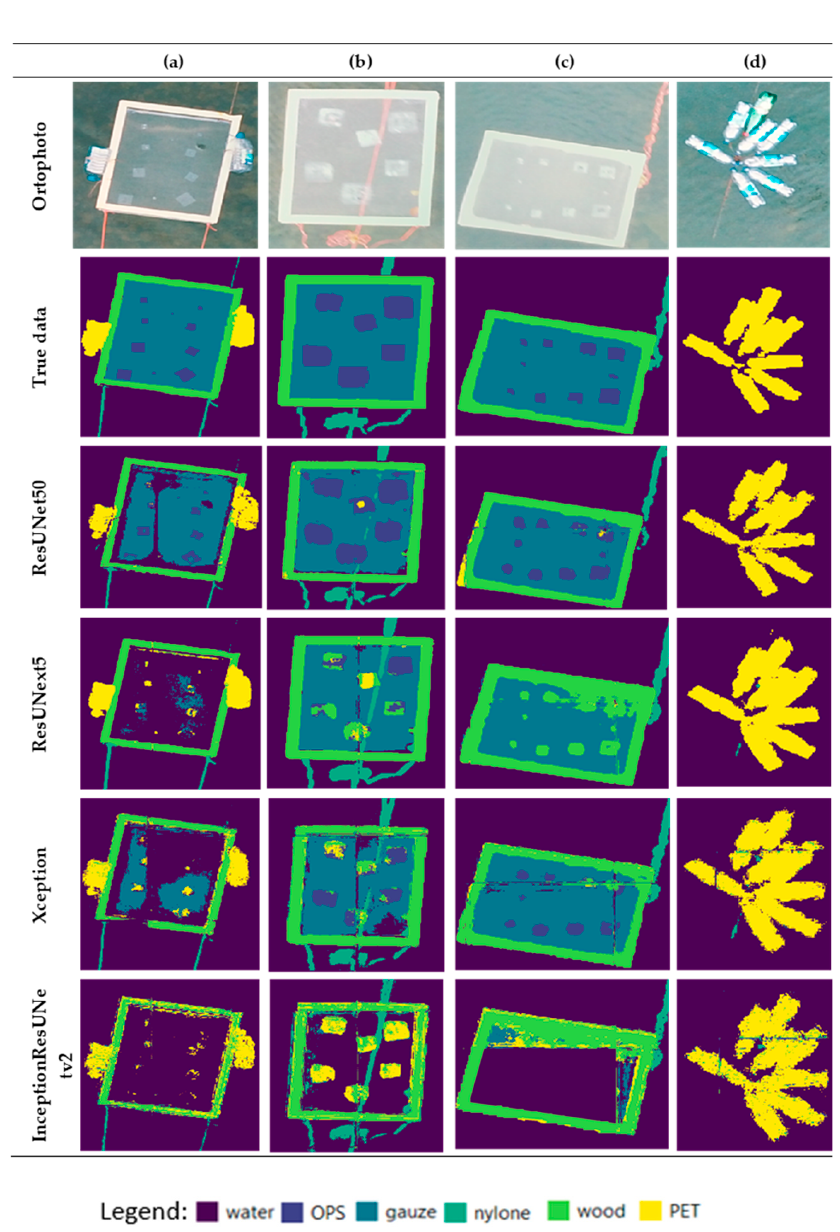
Figure 5. Ground truth data and results of the classification using the four tested models for detecting different plastic materials, located underwater ( a ) and overwater ( b , c , d ) (Dataset 1). Where: OPS is Oriented Polystyrene and PET is Polyethylene terephthalate.